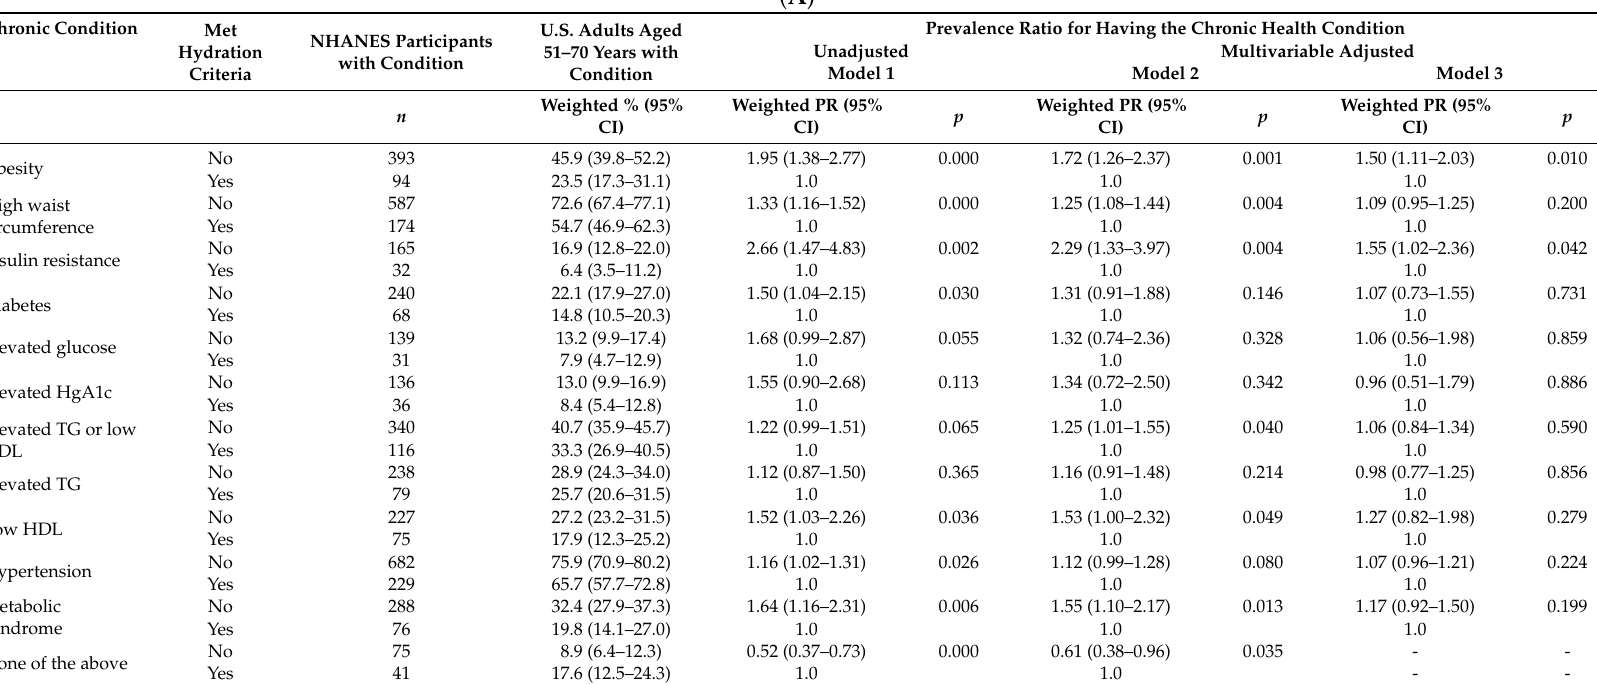
Table 3. (A) Prevalence ratio for selected chronic health conditions associated with not meeting the hydration criteria for fasted U.S. adults aged 51–70 years. (B) Prevalence ratio for selected chronic health conditions associated with underhydration for fasted U.S. adults aged 51–70 years. ( A